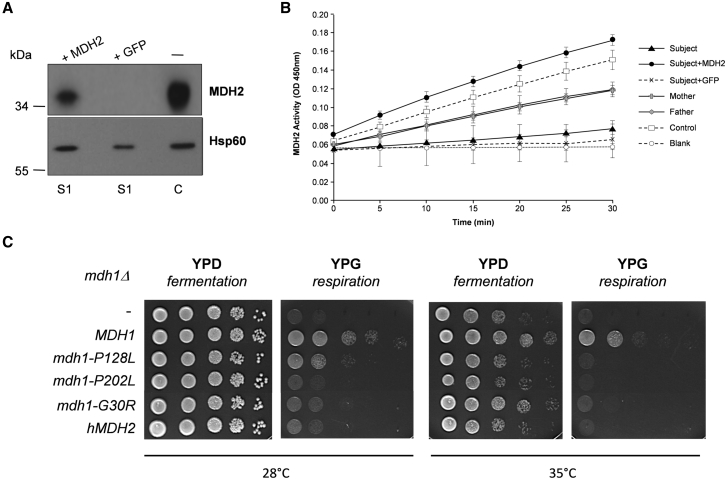
Functional Complementation Showing the Pathogenicity of MDH2 Variants(A and B) Functional complementation of fibroblasts. The human full-length MDH2 cDNA was cloned into the pHR-SIN-CSGW dlNotI vector by PCR (Table S3). Lentiviral particles were produced in HEK293T cells. Then, fibroblasts were infected with viral supernatant expressing either MDH2 cDNA or eGFP (as a control). (A) Restoration of MDH2 levels in S1 fibroblasts transduced with wild-type MDH2 cDNA as determined by western blot with anti-MDH2 antibody. No restoration was observed when cells were transduced with GFP cDNA (C, non-transduced control fibroblasts). (B) Restoration of MDH2 activity in S1 fibroblasts transduced with wild-type MDH2 cDNA (two independent experiments performed in duplicate). No restoration was observed when cells were transduced with GFP cDNA. The MDH2 activity of non-transduced fibroblasts from parents and a control individual is also shown.(C) Functional complementation assay of the yeast mdh1Δ-null mutant. Human MDH2 cDNA was amplified with the corresponding primers (Table S3) and cloned into the centromeric expression plasmid pYX122 (constitutive promoter TPI, Addgene). The yeast wild-type MDH1 and the mdh1 mutated sequences corresponding to the three missense mutations were obtained by PCR (Table S3), and the corresponding fragments were introduced into the linearized pYX122 vector by co-transformation of the mdh1Δ strain (BY4741, Open Biosystems) and homologous recombination. Plasmids from the transformants were extracted and sequenced. These plasmids were then reintroduced into the mdh1Δ strain for testing their complementation capability. Growth of mdh1Δ (−) transformed with wild-type MDH1, mutated mdh1-P128L, mdh1-P202L, or mdh1-G30R, or wild-type hMDH2 plasmids was tested either on glucose (YPD, fermentable carbon source) or on glycerol (YPG, non-fermentable carbon source). Drop dilution growth tests were performed at 1/10 dilution steps and incubated on YPD or YPG plates for 2 days at 28°C or 35°C.